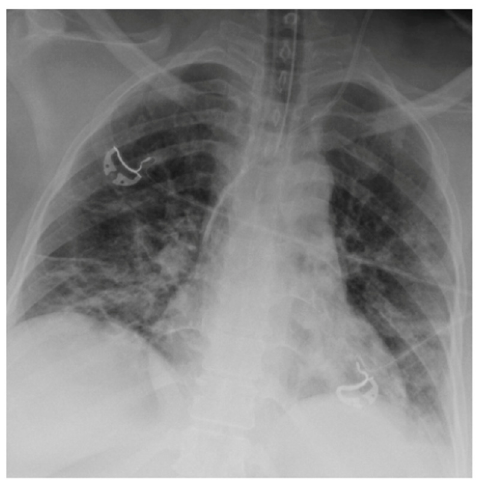
Figure 5. Diffuse bilateral—hazy infiltrates throughout both lungs.